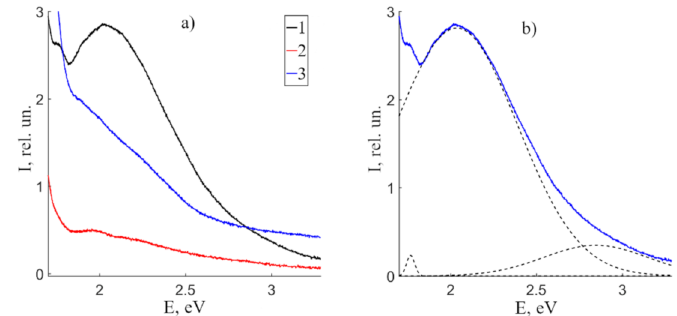
Figure 4. Volume PL spectra of nominally pure CLN (1), SLN (2) and SLN (6.0 wt% K 2 O) (3) crystals ( a ). An example of the of the CLN PL spectrum decomposition into a series of individual maxima ( b ).